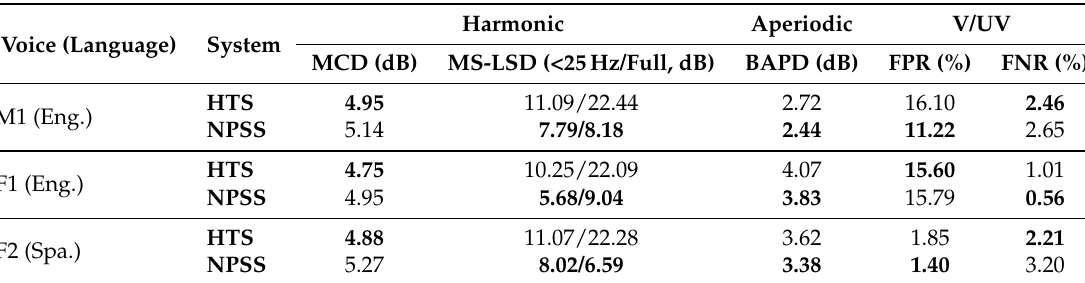
Table 4. Quantitative results for the timbre models trained on pseudo singing, separated by voice/language. The IS16 system is excluded from the quantitative metrics because removing utterances from the dataset to use for testing would mean missing diphones would have to be replaced. The Sinsy-HMM and Sinsy-DNN systems were excluded from this comparison, as the only available models are trained on natural singing. The listed metrics are Mel-Cepstral Distortion (MCD) and Modulation Spectrum Log Spectral Distortion (MS-LSD) for harmonic features, Band Aperiodicity Distortion (BAPD) for aperiodic features, and False Positive Rate (FPR) and False Negative Rate (FNR) for voiced/unvoiced (V/UV)